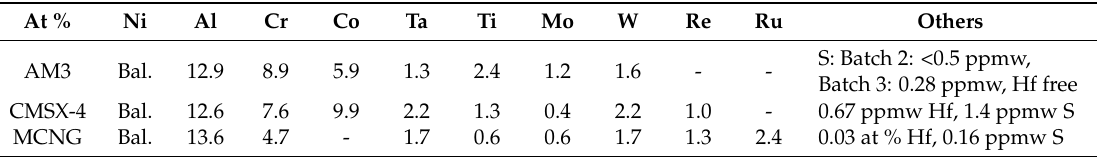
Table 1. Superalloy composition. The Hf concentration of CMSX-4 superalloy was measured by glow discharge mass spectroscopy (GDMS) by Shiva Technology, as well as the sulfur content. At % Ni Al